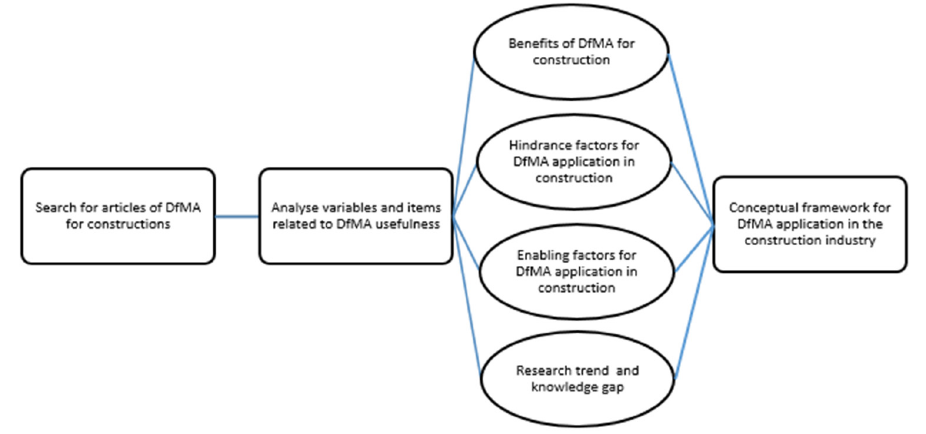
Figure 2. Overall methodology.